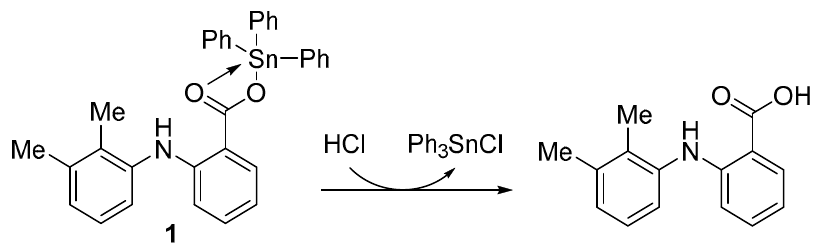
capable of scavenging HCl efficiently (i.e., secondary photostabilizers; Figure 11) [65].